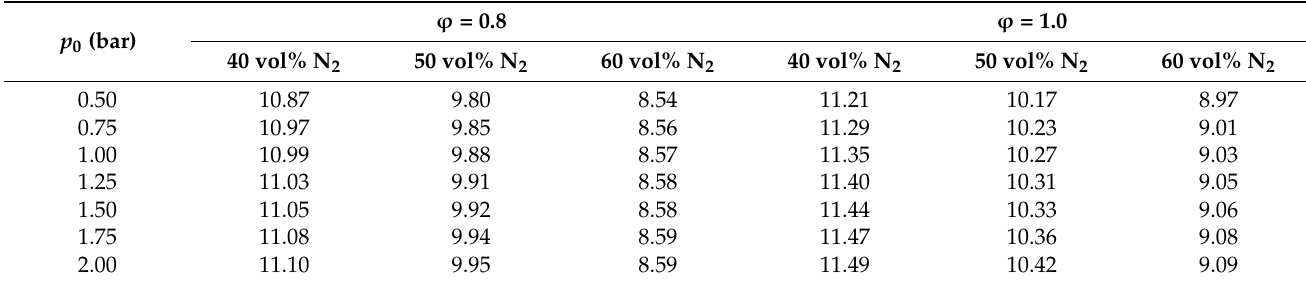
Table 1. Expansion coefficients of deflagrations in N 2 -diluted CH 4 -N 2 O mixtures.